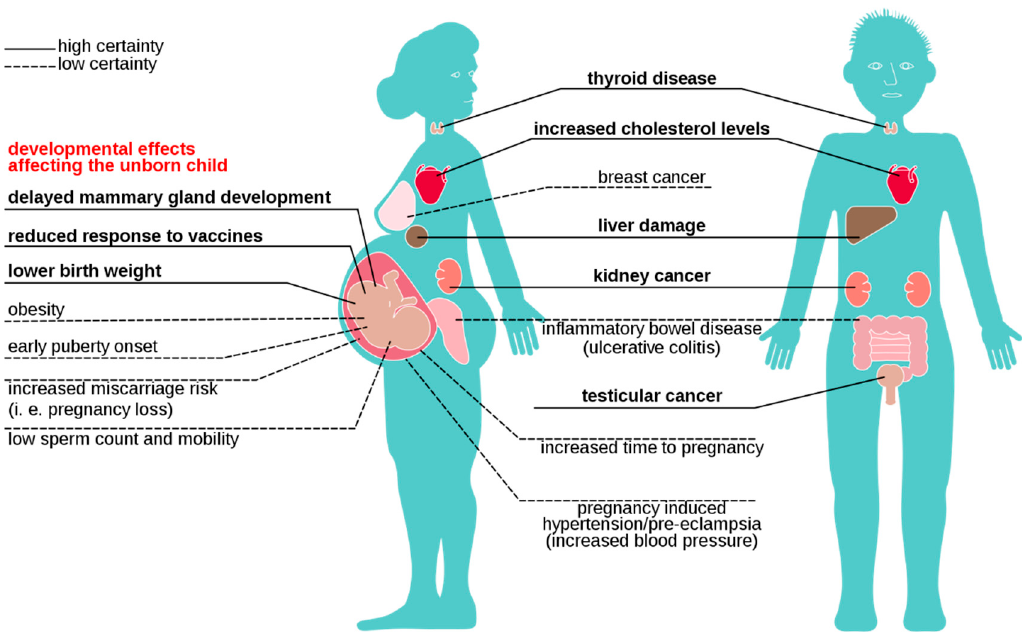
Figure 1. Effects of exposure to PFASs on human health. Some have confirmed certainty (continuous line), while others are still under study (dotted line) [17–22]. (From: https://www.eea.europa.eu/publications/emerging-chemical-risks-in-europe/emerging-chemical-risks-in-europe (accessed on 31 March 2021)).